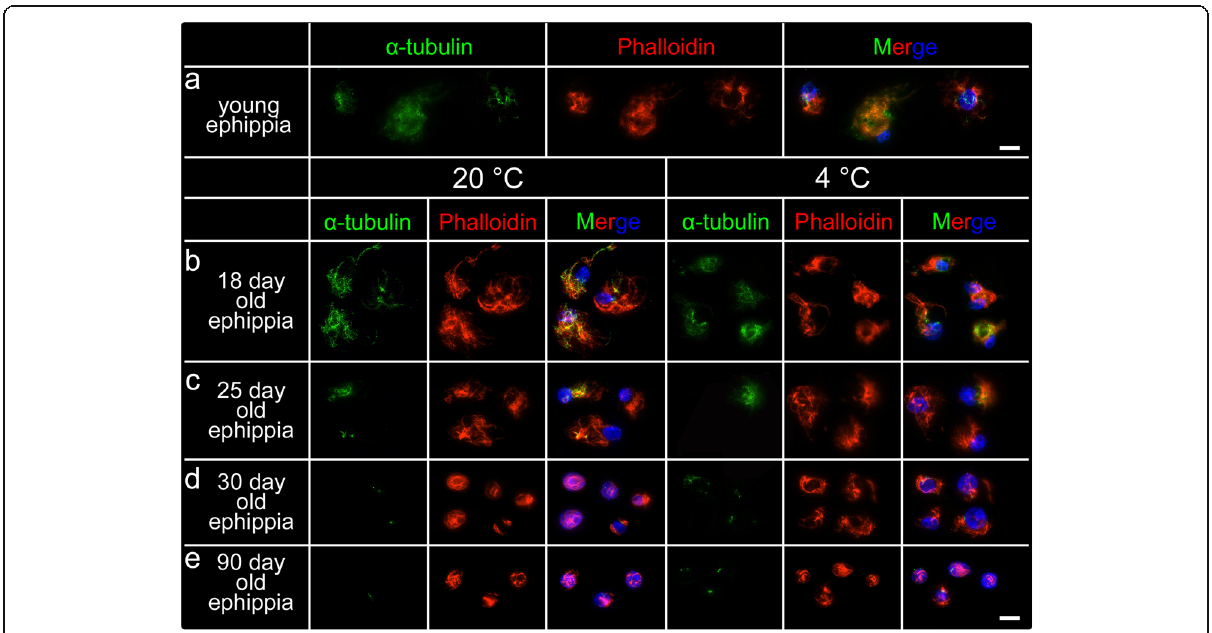
Fig. 4 The changes of cytoskeleton in cells of sexually produced embryos of Daphnia magna over time at two temperatures. a Well-developed cytoskeleton nets were found in cells of young ephippia (about 74 h post ovulation). b After 18-day diapause, the cytoskeleton was still detectable, irrespective of temperature conditions at 20 °C and 4 °C. c Irrespective of temperature, the microtubule-nets were significantly reduced in 25-day diapausing embryos. Only some microtubular residues were still detectable. Actin networks were expanded. d After 30-days of diapause, microtubules were reduced to the centrosome and actin-networks were also reduced in their expansion. e After 90-day, all cytoskeletal elements (microtubules and actin microfilaments) were reduced to a minimum. Scale bars: 10 μ